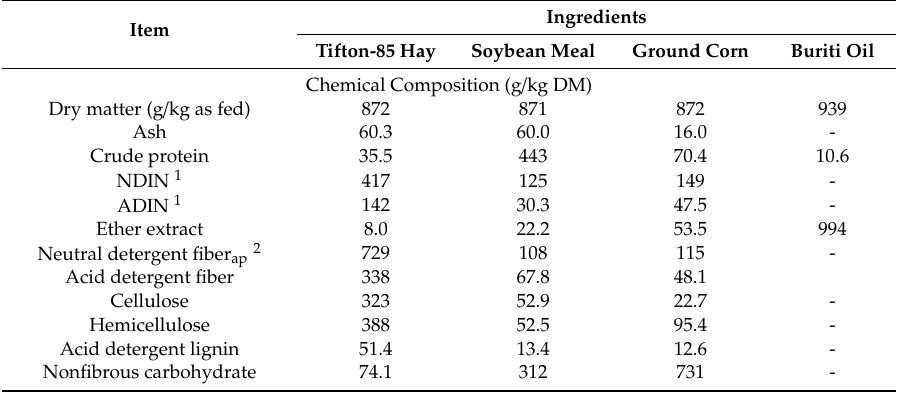
Table 1. Chemical composition and fatty acids composition of ingredients used in lamb